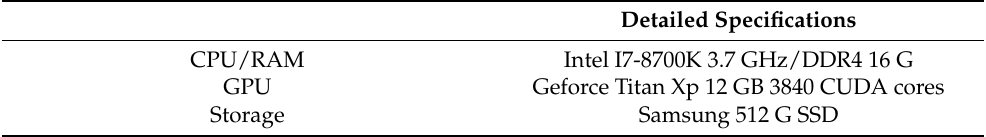
Table 1. Hardware